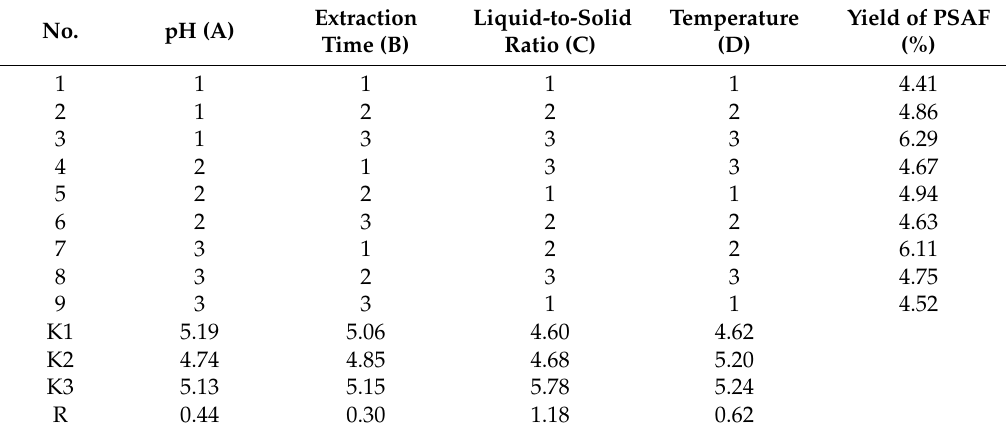
Table 1. Analysis of L 9 (3 4 ) test